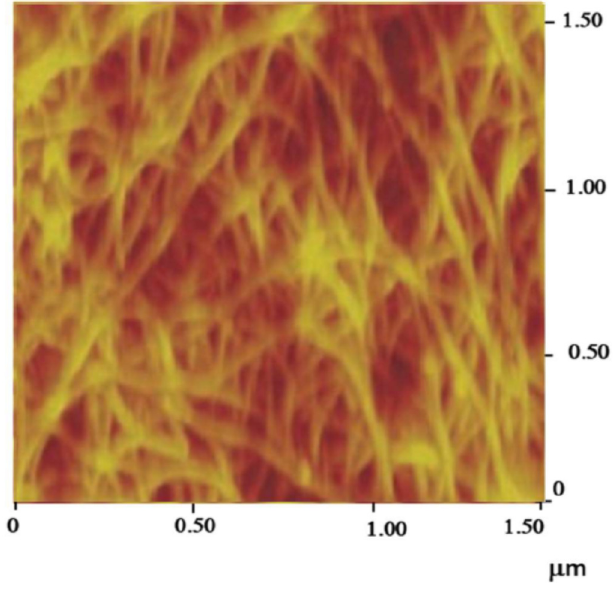
Figure 3. Atomic force microscopy (AFM) image of SWCNT network transferred to a film surface.